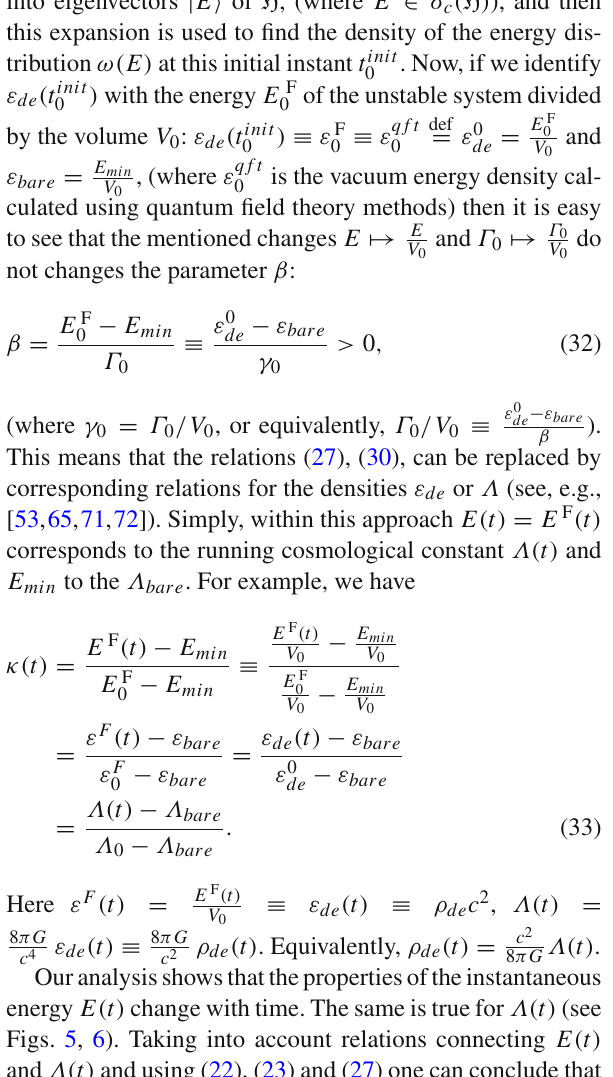
= 0 is expanded 0